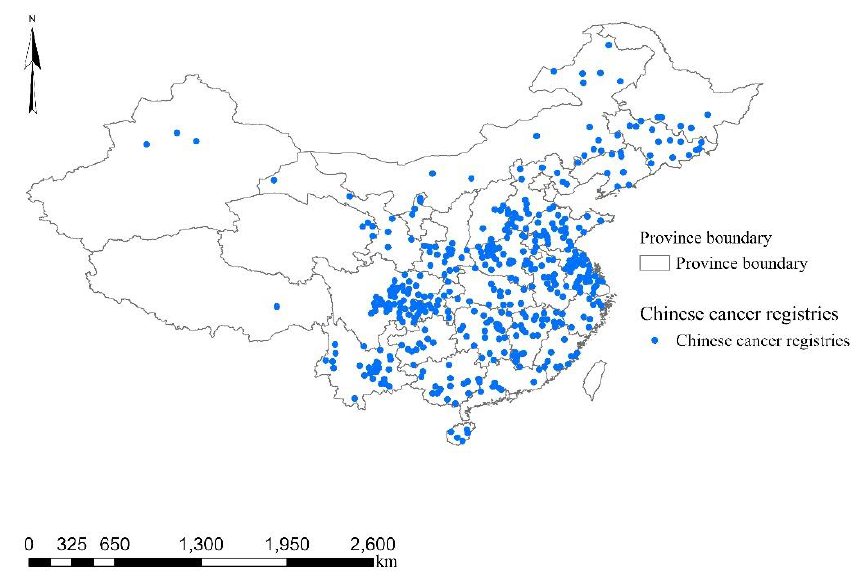
Figure 1. Spatial distributions of 436 Chinese cancer registries during 2014 – 2016.